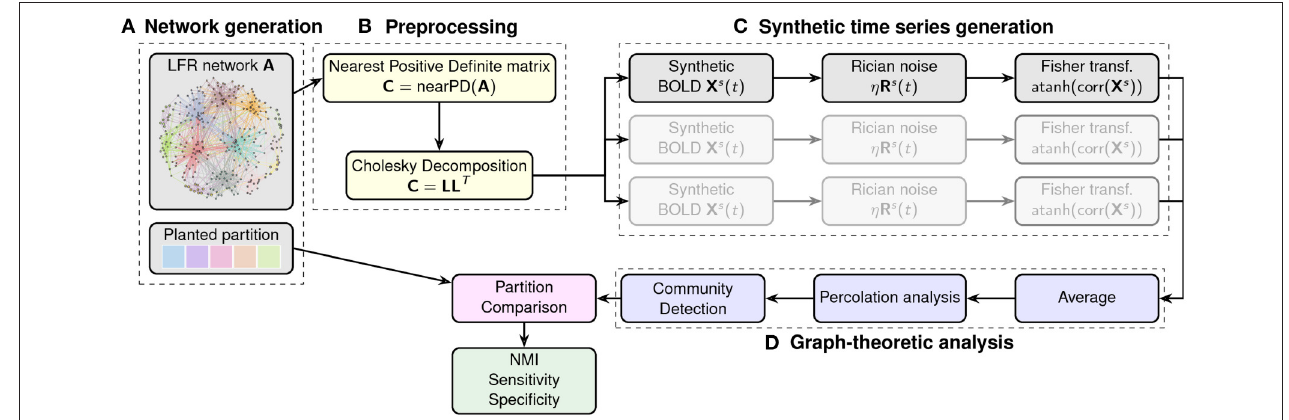
FIGURE 2 | Flowchart of the generation and analysis of the synthetic datasets. In (A) a network with a pre-defined community structure is generated. The adjacency matrix is then processed in block (B) to obtain the nearest positive definite matrix for the Cholesky decomposition. This enables the generation of node-wise time-courses into which different levels of noise can be injected. The procedure is repeated multiple times to generate different instances (mimicking different subjects in the sample). Finally, correlation matrices are calculated for each instance (block C ), and Fisher transformed to calculate the average adjacency matrix for analysis by community detection algorithms (block D ). The resulting partitions are then compared with the original, planted one in terms of NMI.